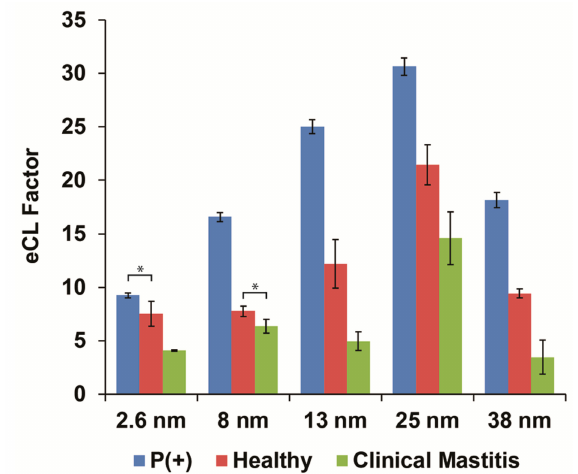
Figure 4. Enhanced CL factor of the various cross-linked GNPs sizes for luminol system within healthy and mastitic milk samples and a positive control (omitting milk from the assay). The enhancement values were calculated with respect to CL values in the absence of cross-linked GNPs, while omitting milk from the assay. Data are reported as mean ± standard deviation ( n ≥ 3). * Significantly di ff erent (t-test, p <